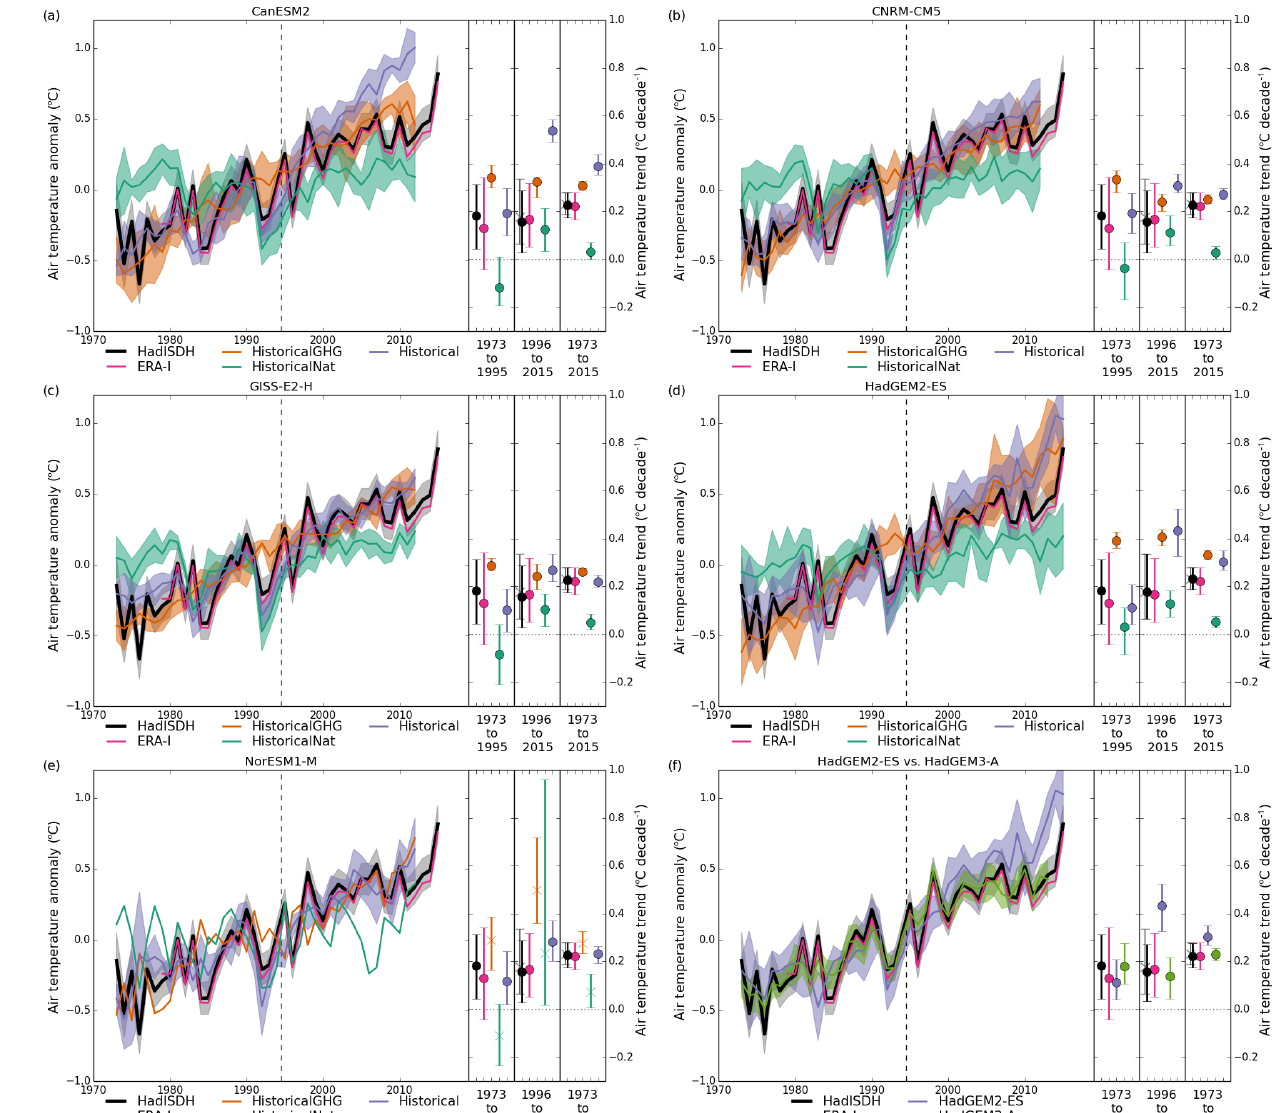
Figure 2. Global annual time series for temperature for five of the nine CMIP5 models and HadGEM3-A using a climatology period of 1976–2005. HadISDH is shown by the thick black line, ERA-Interim by the magenta line, and the historical, historicalNat, and historicalGHG ensemble averages by the purple, green, and orange lines respectively. The uncertainty ranges are shown using the coloured shading. The three scatter plots in the right-hand side of each panel show the values of the linear trends for HadISDH, ERA-Interim and the ensemble averages of all three experiments for the early (1973–1994), late (1995–2015) and full periods. For the late and full period panels, the HadISDH trend is shown matching the temporal coverage of the historical model (circle) and its full coverage (cross). If there is only one ensemble member for the model, then the trend is marked with a cross rather than